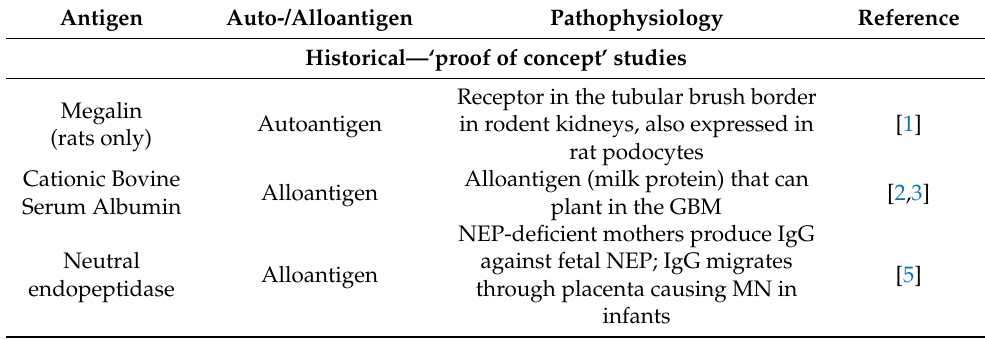
Table 1. Historical auto- and alloantigens in MN.